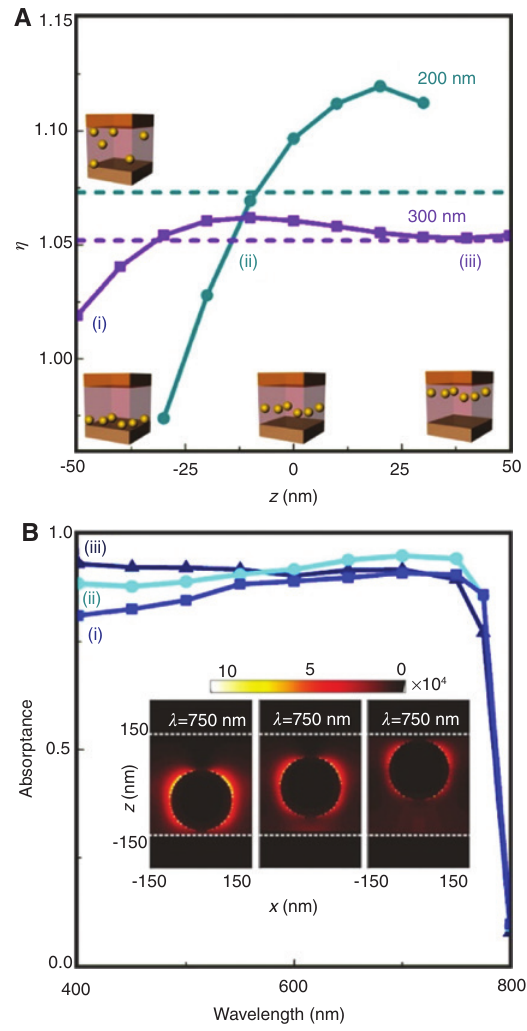
Figure 24: (A) Perovskite solar absorption enhancement, η , as a function of the z position of the AuNP inside the perovskite slab. Circles account for a 200 × 200 × 200-nm 3 system with a sphere of r = 60 nm and squares for a 300 × 300 × 300 nm 3 with a sphere of r = 90nm. Dashed lines correspond to the average value for all z posi- tions in each case. (B) For the 300 × 300 × 300-nm 3 case, absorption spectra at several z positions, (i) z = −50 nm, (ii) z = −10 nm, and (iii) z = + 50 nm. Colors correspond to the positions indicated in panel (A). The inset displays corresponding absorption profile at λ = 750